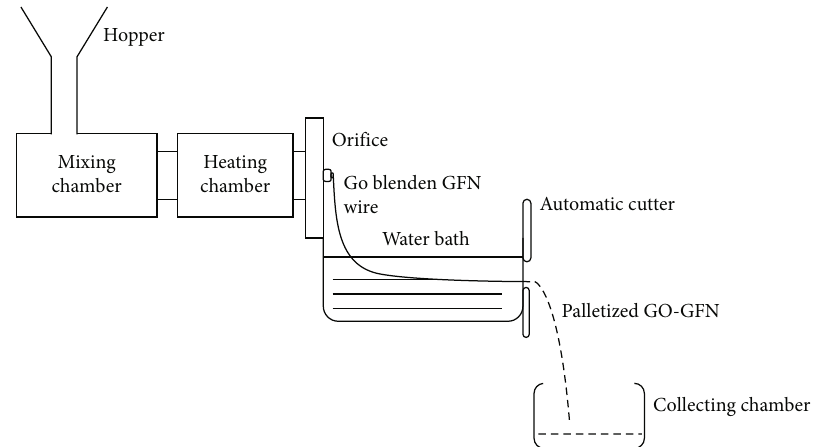
Figure 1: Synthetization process of GO-GFN nanopolymer